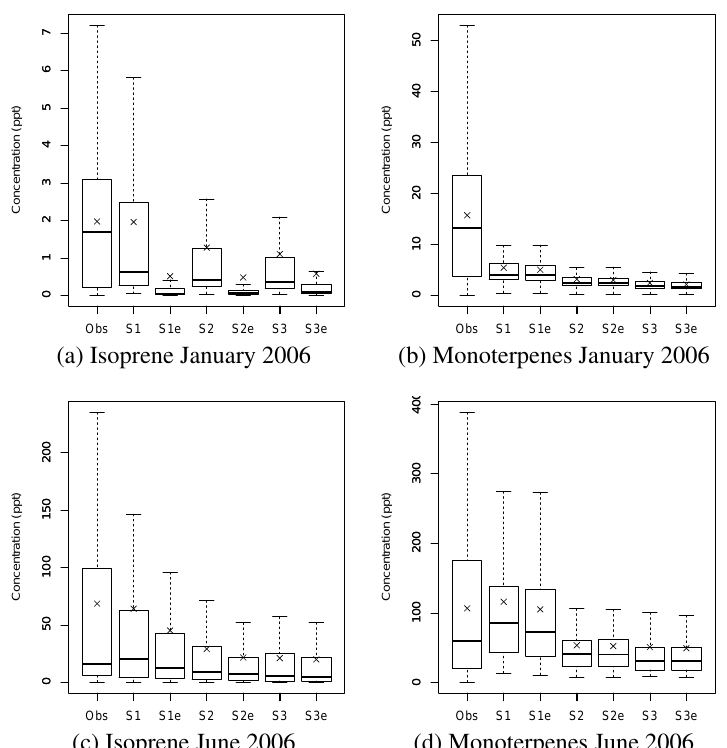
Fig. 9. Observed (Obs) versus modelled concentrations at Hohenpeissenberg for S1–S3 and the corresponding scenarios with enzyme seasonality S1e–S3e. The boxes indicate the interquartile range, the median is the horizontal line in the box and the crosses indicate the averages. The whiskers extend to a value that is 1.5 times the interquartile range from the box. This can be explained by the fact that higher temperatures in winter allow to compensate for less light, while in summer, the emissions